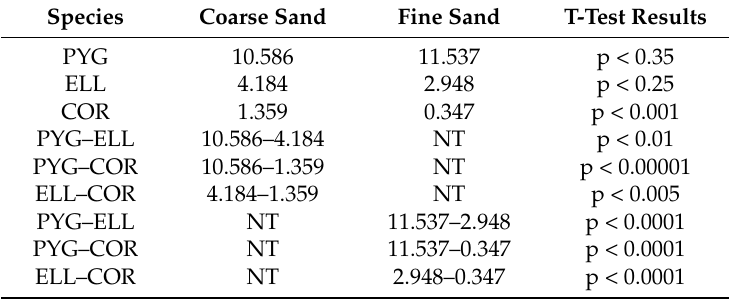
Table 9. Comparisons of slopes of linear regression best fit lines for data sets plotted in Figure 14. t-test results given here indicate whether the slopes of the BL burial depths vs ET regressions are significantly different from one another using the procedure of Zar (1974, p. 228). ET—escape time in Pyganodon cataracta . ELL: Elliptio complanata . COR: Corbicula fluminea . Top tier of the table compares the